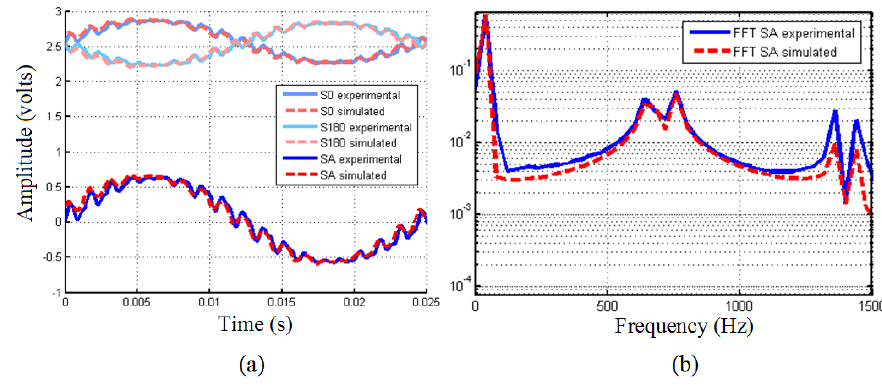
Figure 1. ( a ) Experimental signals (cid:1845) resultant measurement signal (cid:1845) experimental and simulated measurement signal (cid:1845)